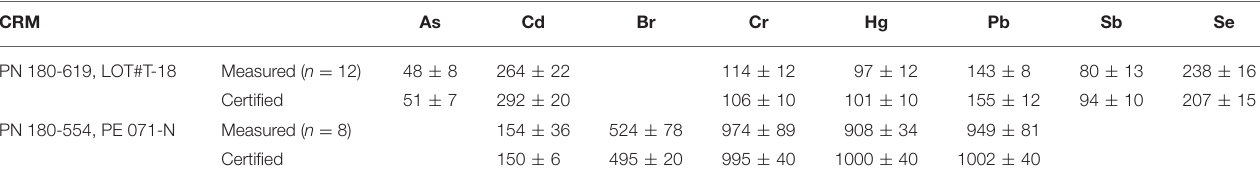
TABLE 2 | A comparison of measured and certified concentrations of elements in two Niton reference plastic discs, with errors representing two standard deviations about the mean in all cases. CRM As Cd Br